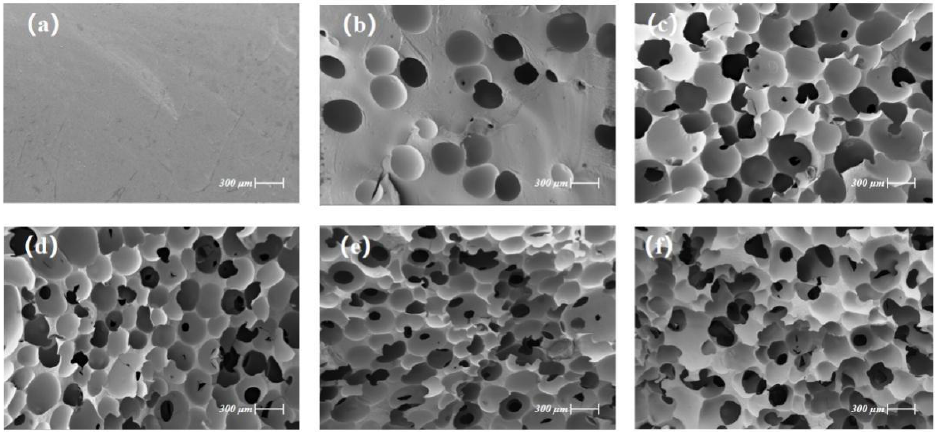
Figure 5. Scanning electron microscopy (SEM) analysis of PU and PU/FA composites: ( a ) PU; ( b ) PU/FA-10%; ( c ) PU/FA-20%; ( d ) PU/FA-30%; ( e ) PU/FA-40%; and ( f ) PU/FA-50%.